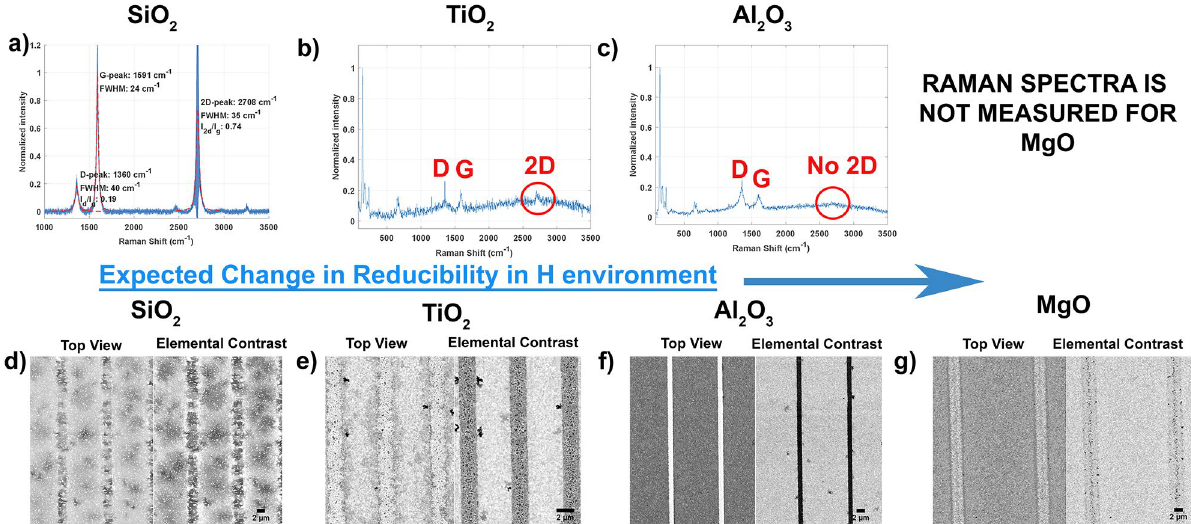
Figure 5. Reduction in the H environment follows the trend as SiO 2 > TiO 2 > Al 2 O 3 > MgO 31 . ( d ) Schematic view shows the presence of O–H bonds with respect to reduction on oxide surface. Raman results are given, indicating MLG growth for SiO 2 patterned sample ( a ), local growth with the appearance of small 2D peak for TiO 2 patterned sample ( b ) and no growth for Al 2 O 3 patterned sample ( c ). SEM results after CVD process is given with ( d ) SiO 2 , ( e ) TiO 2 , ( f ) Al 2 O 3 , ( g ) MgO lines on Mo 2 C, showing the C species with dark contrast in elemental contrast mode